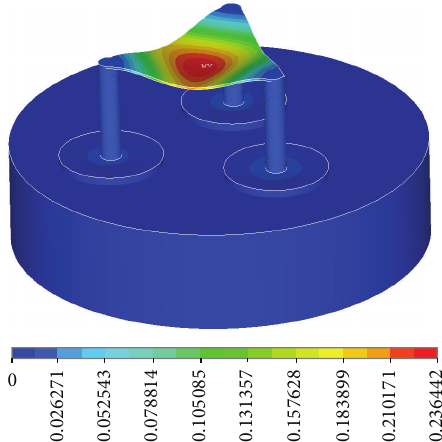
Figure 10: Displacement Vector Sum (Nodal Solution).